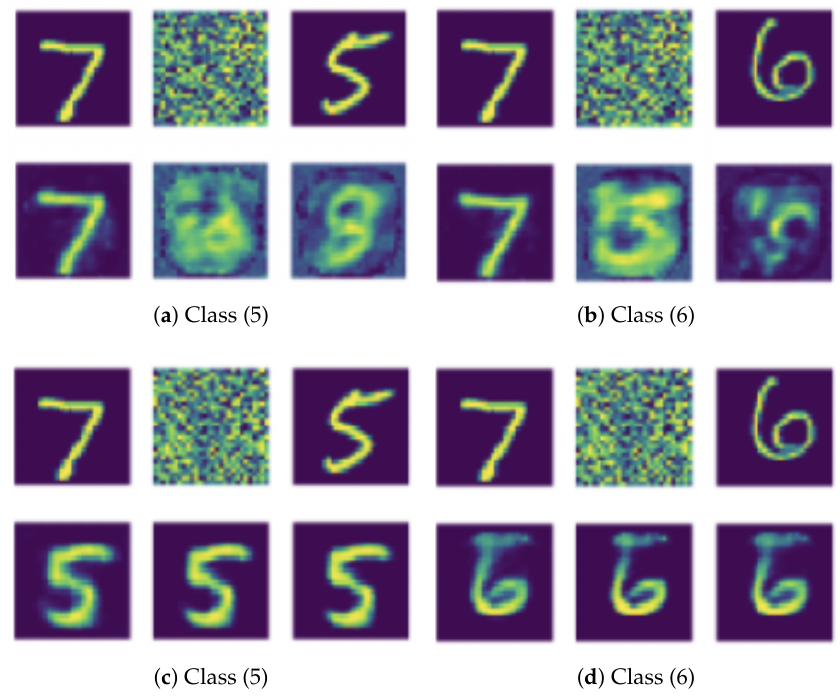
Figure 2. An ablation study ( Top ) and an insertion study ( Bottom ) with different examples and different identification of class pathway on the MNIST dataset.